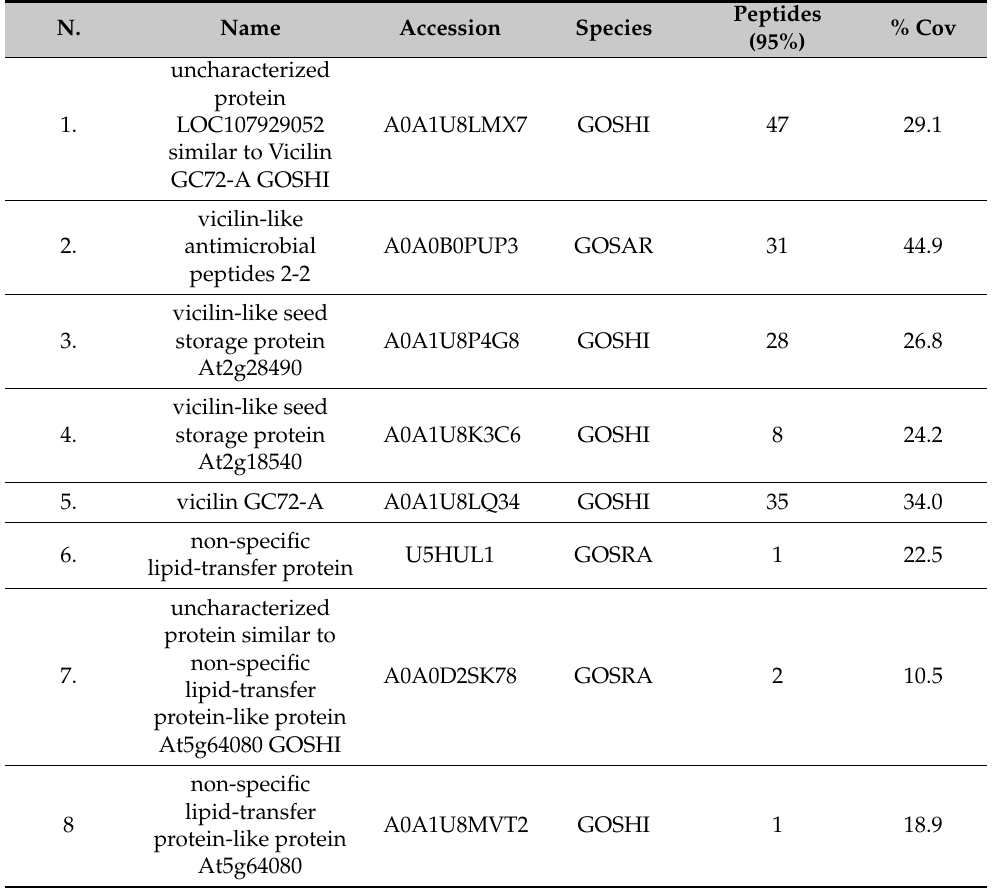
Table 2. Proteins and peptides identified as vicillins and lipid transfer proteins present in the PSE (according to the Malvales database, Uniprot). The table takes into account the parameters characterizing the proteins and peptides: the number of identified peptides (95% confidence) and the percentage of peptide sequence